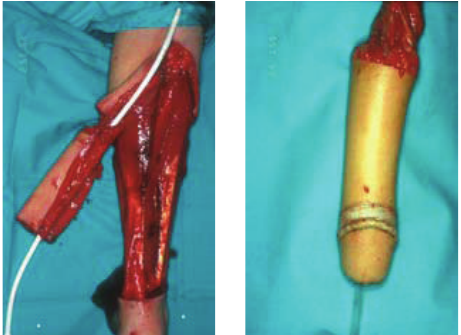
Figure 2: The radial forearm free flap using the tube-in-a-tube principle for creation of the neourethra.